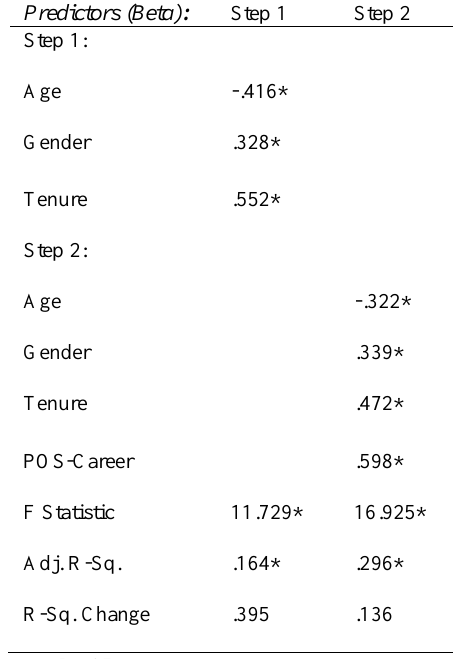
Table 4: Hierarchical Regressions for POS-Career and Subjective Career Success